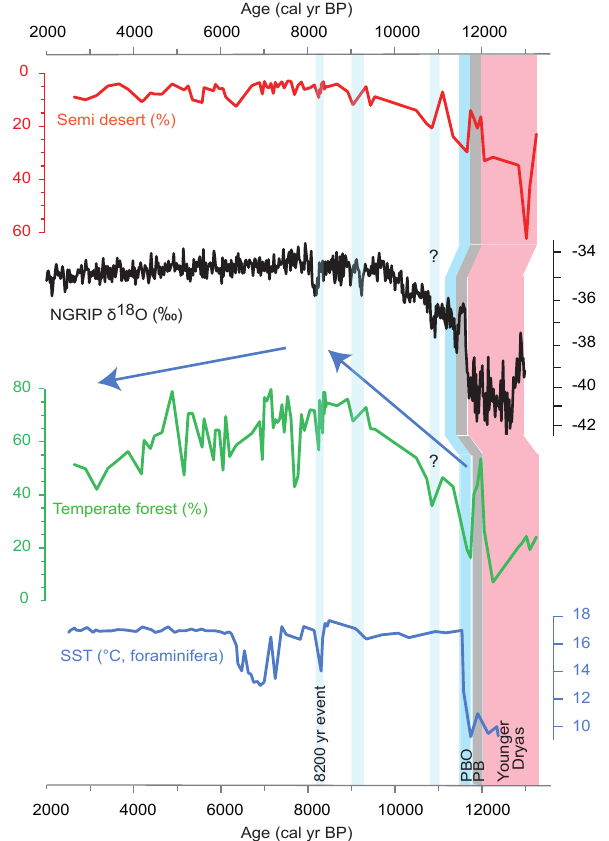
Fig. 5. Comparison between two main pollen groups (this paper); temperate trees (green), semi-desert (red) and SST (blue) from the core MD 90-917 and NGRIP oxygen isotope record (NGRIP mem- bers, 2004; Lemieux Dudon, 2011). Colored bars underline climate events: YD (pink), PB (grey), PBO and 8200 cal yr BP event (pur- ple). Curves are plotted according to their respective age models in cal year BP. The time lag observed between MD 90-917 and NGRIP records during the YD–Holocene transition is probably due to 14 C age uncertainties displayed in the MD 90-917 age model. The ques- tion marks indicate potential events not sufficiently documented in the